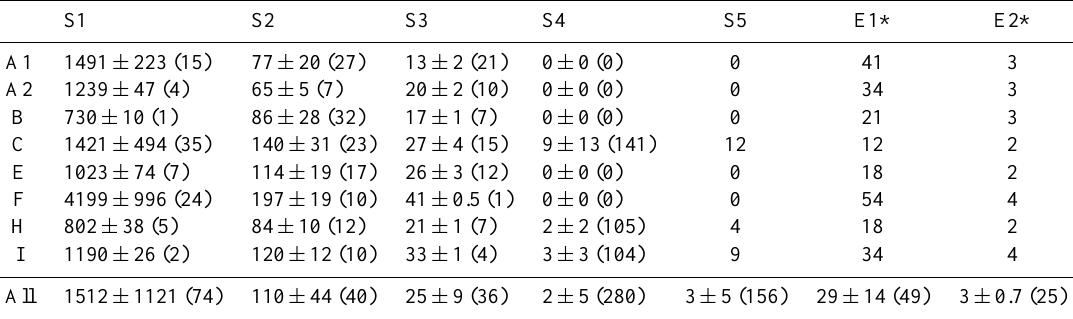
Table 3. Summary of IP 25 concentrations (ngg − 1 ) for all sediments and laboratories. Values correspond to mean ± sd (%RSD) and have been obtained using 7-HND as an internal standard. Values are either rounded to the nearest integer ( > 1) or shown to 1 significant figure ( < 1). Data for S5, E1 and E2 from individual laboratories are single measurements. * Relative concentrations.